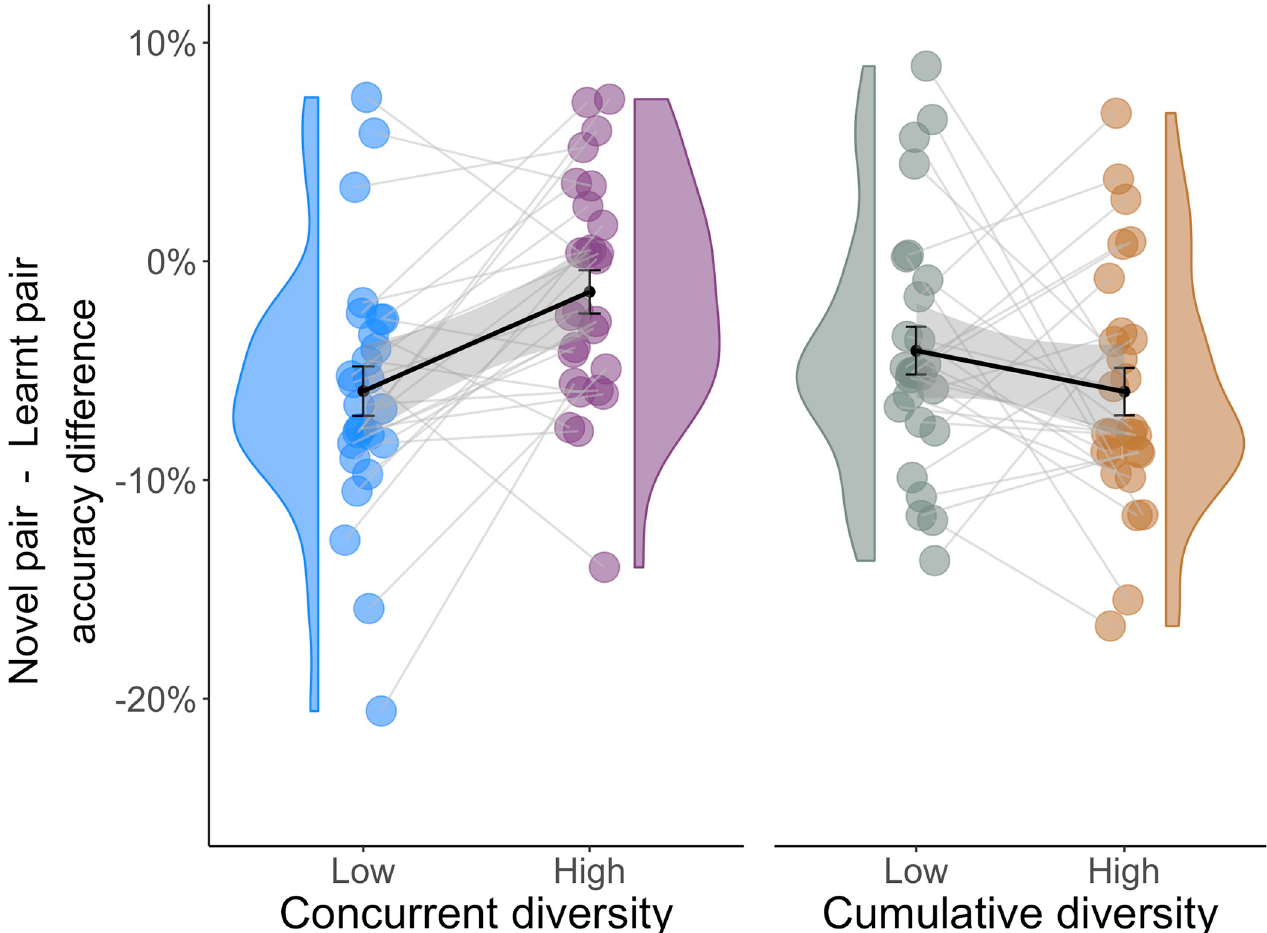
Fig 3. Generalization performance. n = 27 subjects. Drop-off in accuracy in novel-pair compared to learned-pair testing trials, as a function of training diversity. Concurrent diversity had a significant effect on this measure of generalization (p corrected = .004, bootstrap test) whereas cumulative diversity did not significantly affect it (p corrected = .29, bootstrap test). The plot shows individual subject accuracy (circles), group distributions of accuracy levels (violin), group means (thick lines) and standard errors (gray shading).